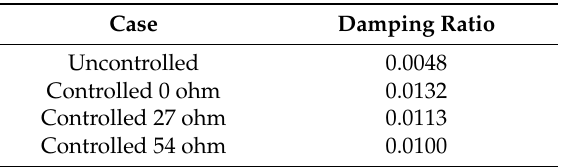
Figure 9. Free-vibration response of the cable (middle point, ½ L). Table 5. Damping ratio variation.